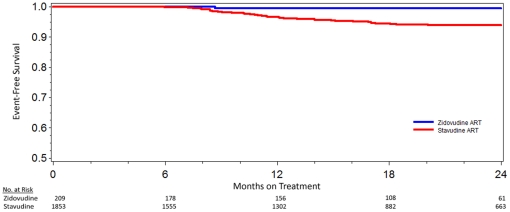
Kaplan Meier curves for lactic acidosis/hyperlactatemia-free survival
for patients initiated on either stavudine- or zidovudine-containing
antiretroviral therapy (p = .006).